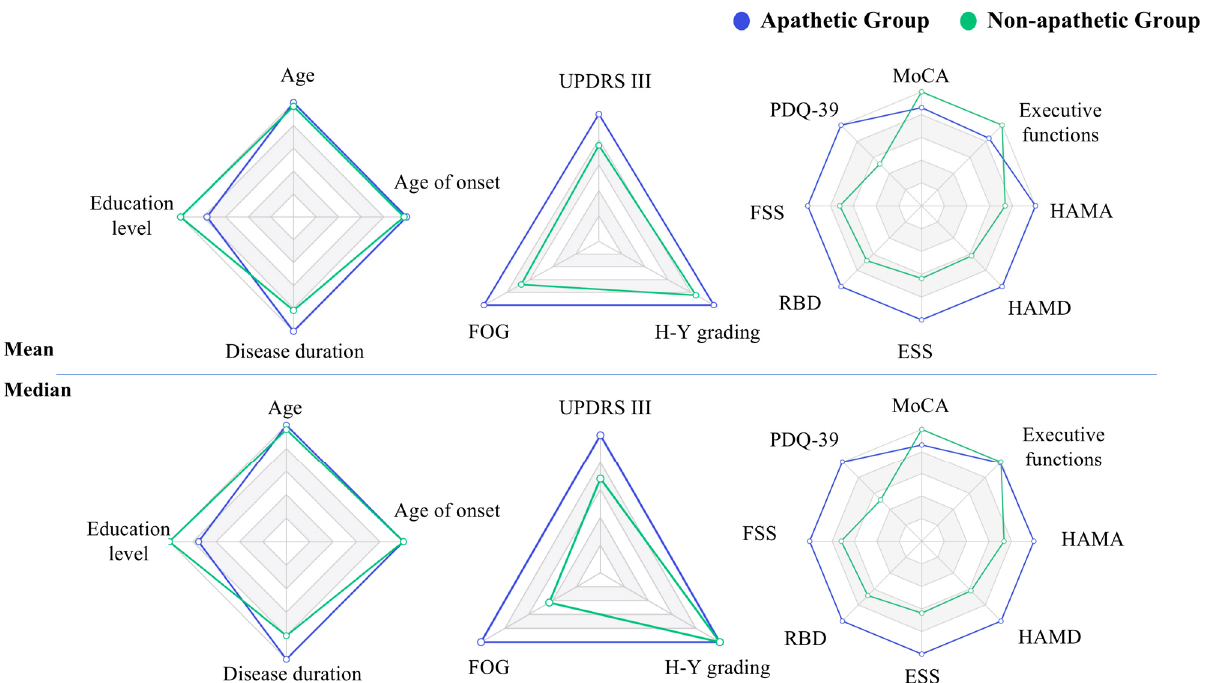
Figure 1. Radar maps of mean and